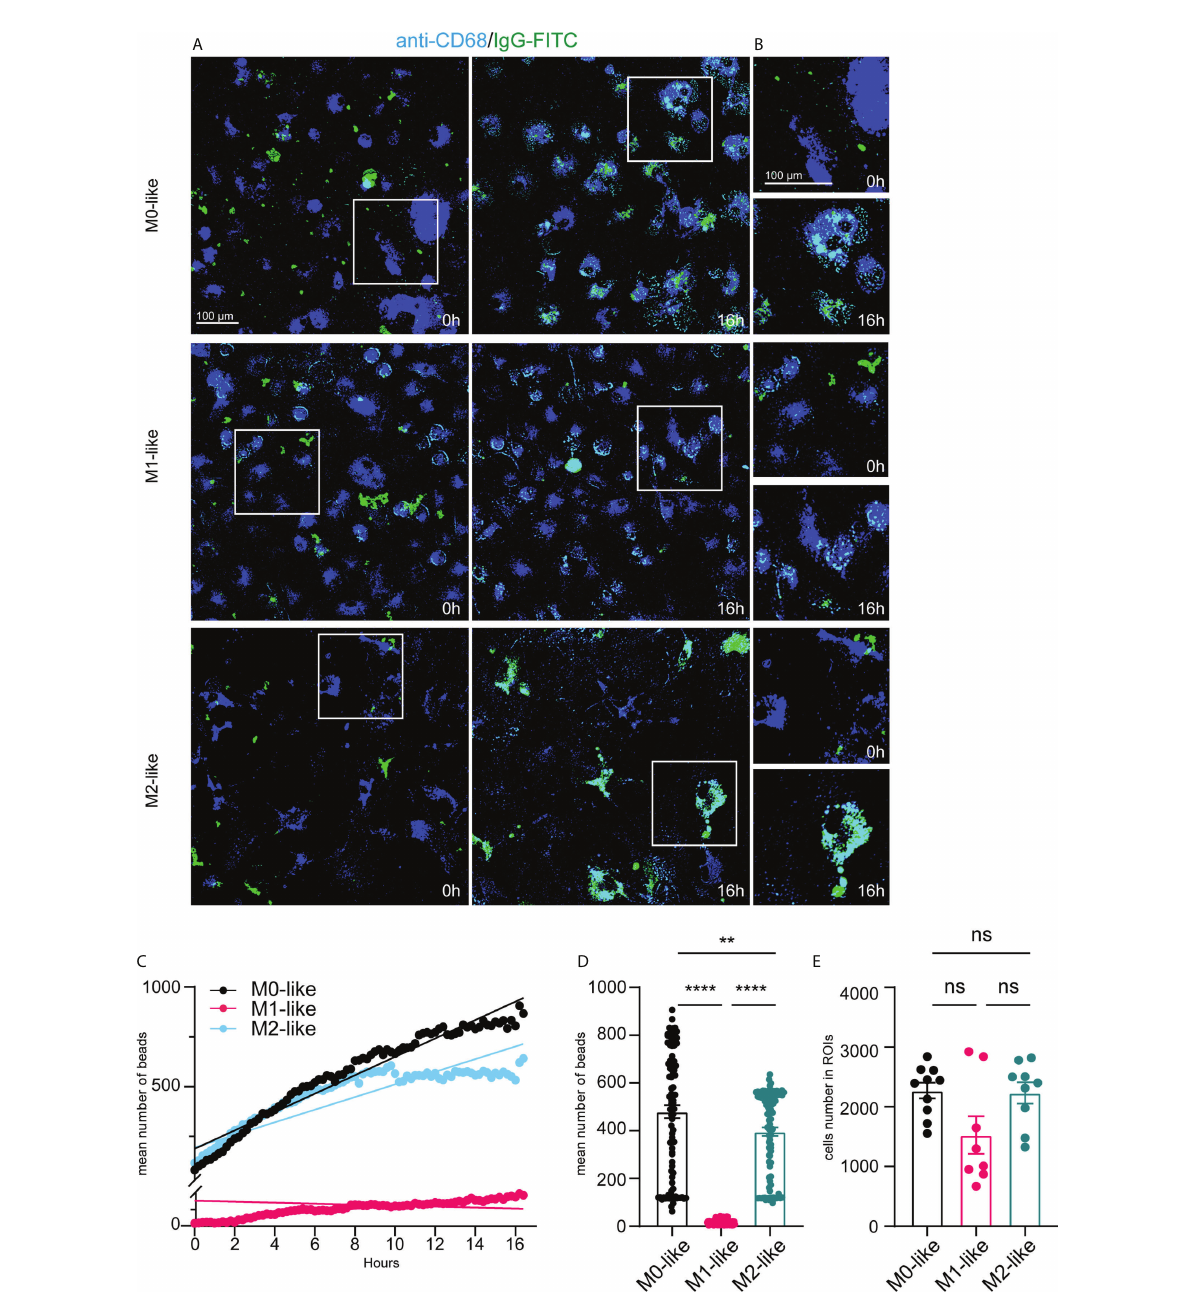
FIGURE 5 Microglia subtypes show different phagocytosis capacities and dynamics for IgG-FITC beads over 16 hours. (A) Single frame images and (B) image enlargements from live imaging movies of anti-CD68 live-immunolabelled microglia (blue) after addition of IgG-FITC beads (green) at time-points 0h and 16 h, scale bar, 100µm. Note pronounced IgG bead accumulation in M0- and M2- but not in M1-like microglia at 16h after addition of E.coli particles. (C) Time-series plot showing the mean number of IgG beads internalized (averaged from 8-10 ROIs for each time interval) by microglia subtypes over 16 hours. Simple linear regression calculation indicate different slopes of phagocytic capacities of M0- (black) (r 2 : 0,1637, p < 0,0001), M1- (pink) (r 2 : 0,2733, p < 0,0001), and M2-like (cyan) (r 2 : 0,07045, p < 0,0001), respectively. Note that M2-like microglia discontinued internalization at about 9 hours after addition of IgG-FITC beads. (D) Mean number of internalized particles over 16 hours (averaged from 8-10 ROIs for each time interval). (E) Number of imaged anti-CD68 immunolabelled microglia encountering IgG-FITC beads over 16 hours. Data are expressed as means ± SEM, one-way ANOVA ( post-hoc correction Holm-S ̌ ı ́ da ́ k test, ****p < 0.0001. ns, not signi fi